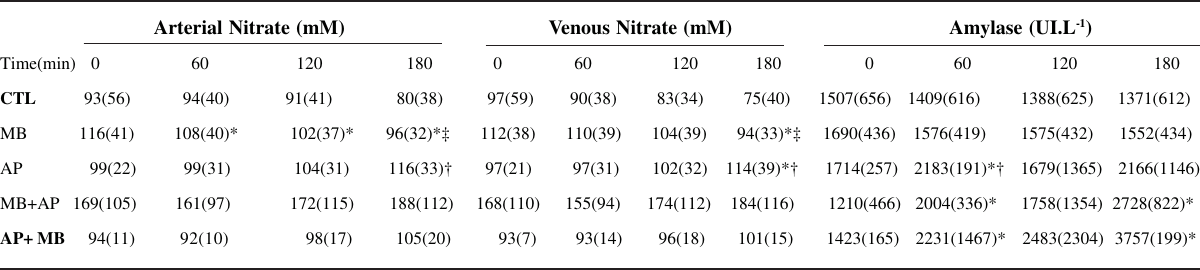
TABLE 2 - Serum arterial and venous nitrate and serum amylase results in all groups. Arterial Nitrate (mM) Venous Nitrate (mM)